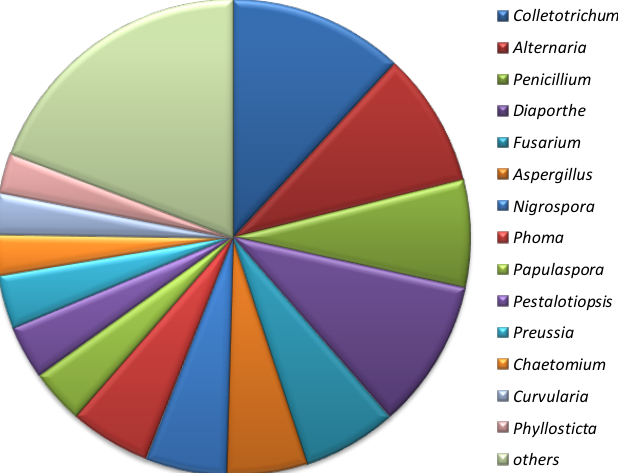
Figure 2. The frequency of isolation of endophytes (%) from Asteraceae host plants. The others: Acremonium , Ampelomyces , Bipolaris , Botryosphaeria , Botrytis , Calonectria , Cercospora , Coniochaeta , Cylindrocarpon , Epicoccum , Exserohilum , Memnoniella , Paecilomyces , Periconia , Podospora , Pezicula , Pyrenophora , Scopulariopsis , Seiridium , Trichoderma , Xylaria (based on references cited in this review).